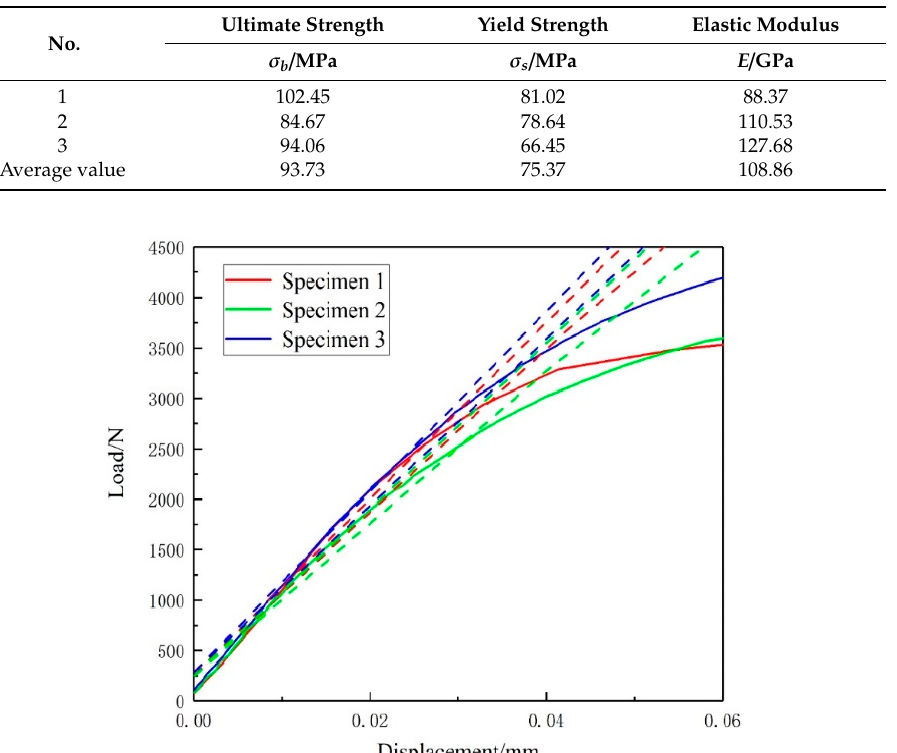
Table 3. Tensile test results.